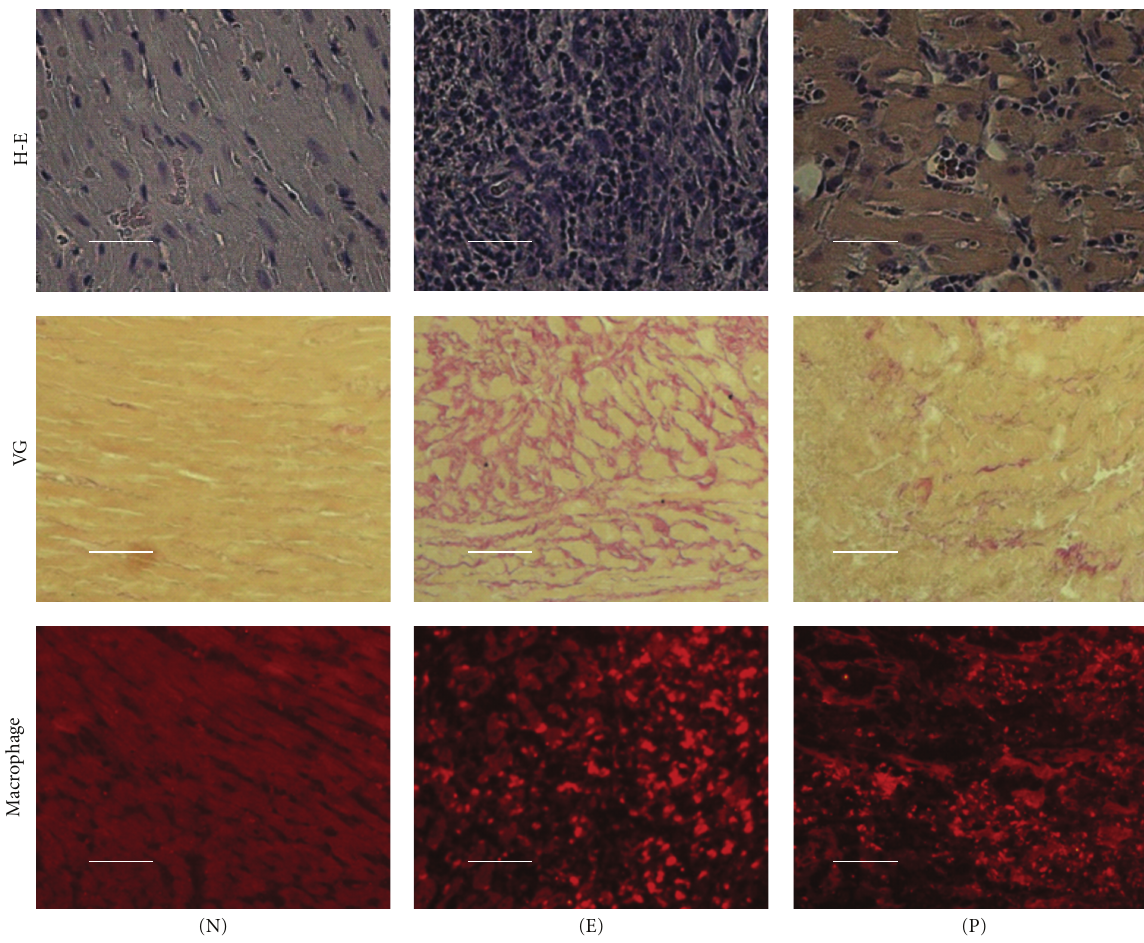
Figure 2: Histopathology of the heart section of experimental myocarditis [78]. (N); control heart, (E); heart from experimental myocarditis treated with saline, (P); heart from experimental myocarditis treated with pioglitazone. The upper panel shows hematoxylin-eosin staining (scale bars indicate 200 μ m), the middle panel shows van Gieson staining (scale bars indicate 400 μ m), and the lower panel shows immunostaining of infiltration of inflammatory macrophages (scale bars indicate 200 μ m) in the heart of experimental myocarditis rats. The degree of inflammation, fibrosis and infiltration of inflammatory macrophages was significantly improved by the treatment with